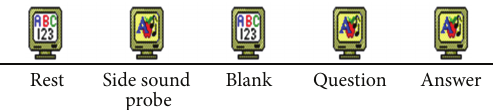
Figure 2: Experiment steps designed by